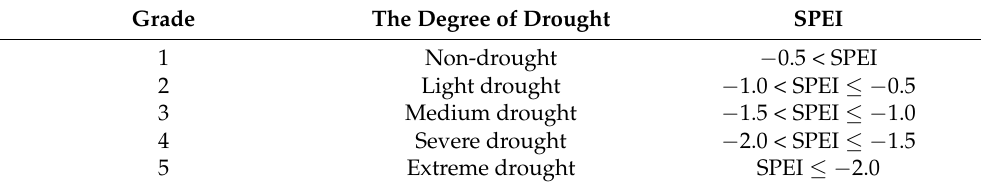
Table 2. SPEI drought grade classification